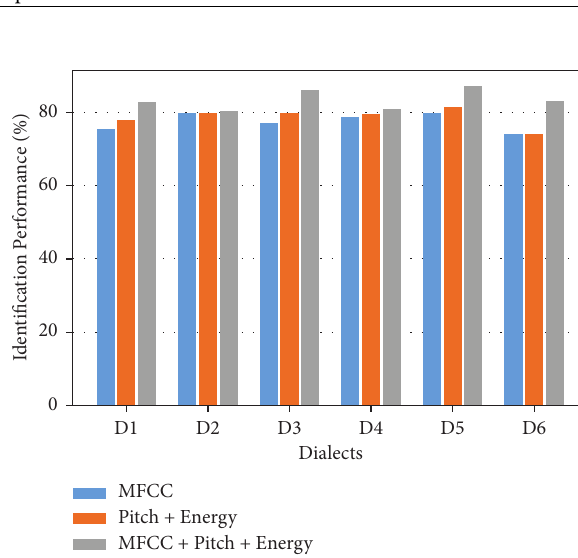
Figure 9: Identification performance of dialect identification system with a different set of features.